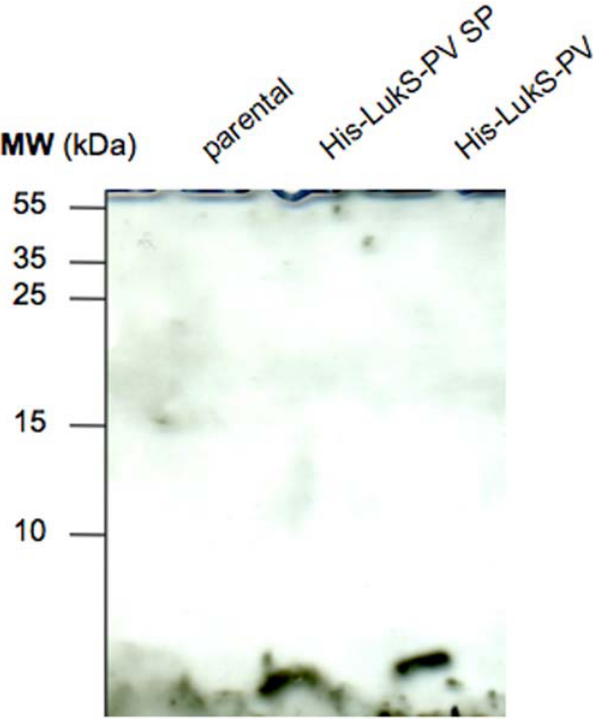
Figure 9. The signal peptide is present in cell wall associated material. The 2% SDS extract of various strains were run on 17% SDS PAGE, transferred to nylon membrane and probed with mouse monoclonal anti-poly His antibody (1:500) (Sigma) followed by goat anti mouse HRP conjugated antibody (1:2000) (Sigma). Parental (LUG960) indicates the genetic background in which the genetic modifications were made; His-LukS-PV SP, parental carrying a plasmid encoding the His-tagged LukS-PV signal peptide alone; His-LukS-PV, parental carrying a plasmid encoding the His-tagged full length LukS-